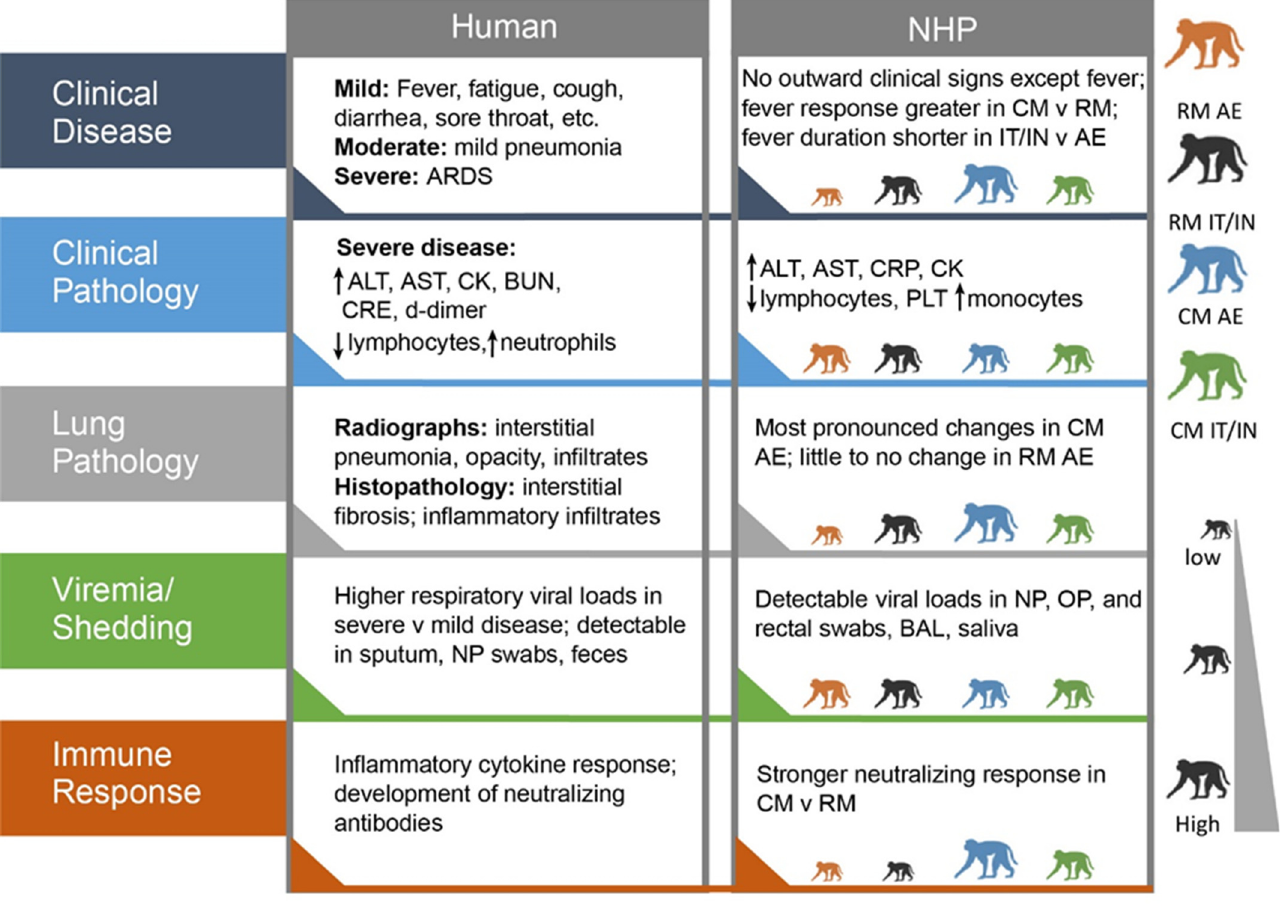
Figure S5: Representative pathology in the rhesus macaques (RM) intratracheal/intranasal (IT/IN) exposure group; Figure S6: Representative pathology in the cynomolgus macaques (CM) intratra- cheal/intranasal (IT/IN) exposure group; Figure S7: Infection of rhesus (RM) and cynomolgus macaques (CM) with SARS-CoV-2 by aerosol (AE) or intratracheal/intranasal (IT/IN) exposure; Figure S8: Clinical pathology in rhesus (RM) and cynomolgus macaques (CM) infected with SARS- CoV-2 by aerosol (AE) or intratracheal/intranasal (IT/IN) exposure; Figure S9: Changes in activity levels of rhesus macaques (RM) infected with SARS-CoV-2 by aerosol (AE) or intratracheal/intranasal (IT/IN) exposure; Figure S10: Changes in activity levels of cynomolgus macaques (CM)